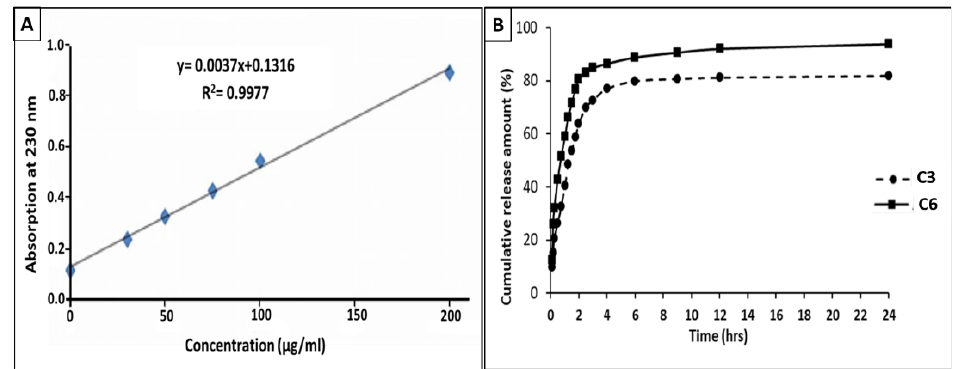
Figure 6. ( A ) Calibration curve of silver nitrate adsorption at 230 nm relative to the concentration and ( B ) Cumulative percentage of silver nitrate release from hydrogels A3 and A6 relative to time.